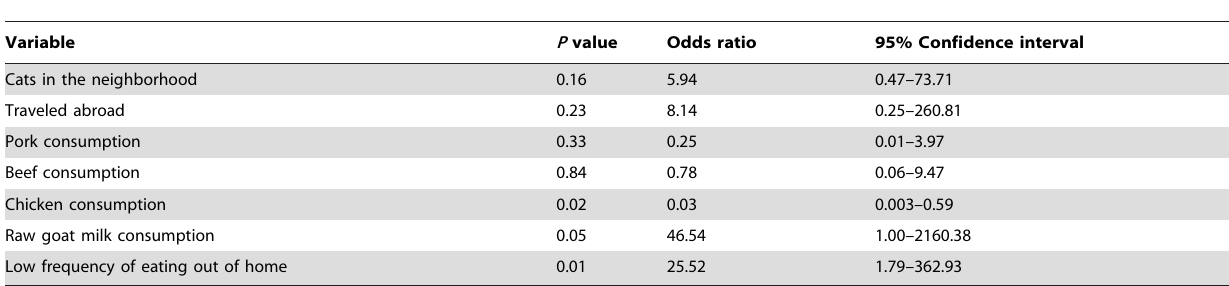
Table 4. Results of multivariate